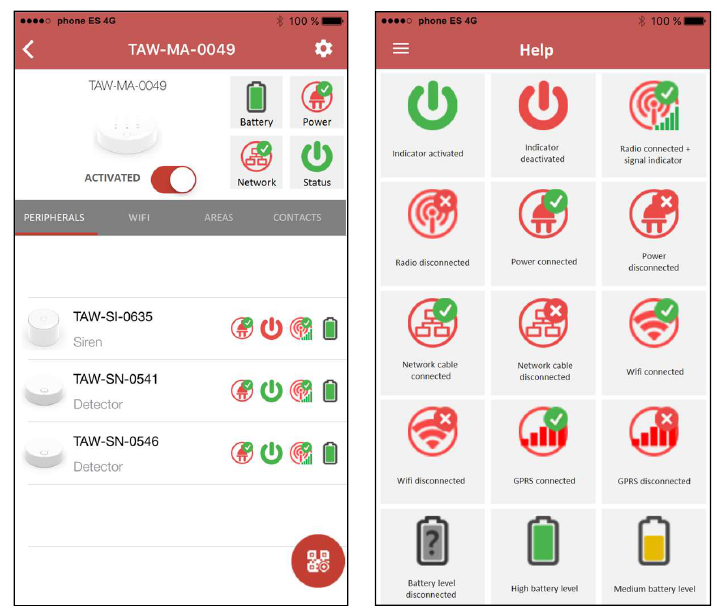
Figure 12. Some views of the mobile monitoring application.